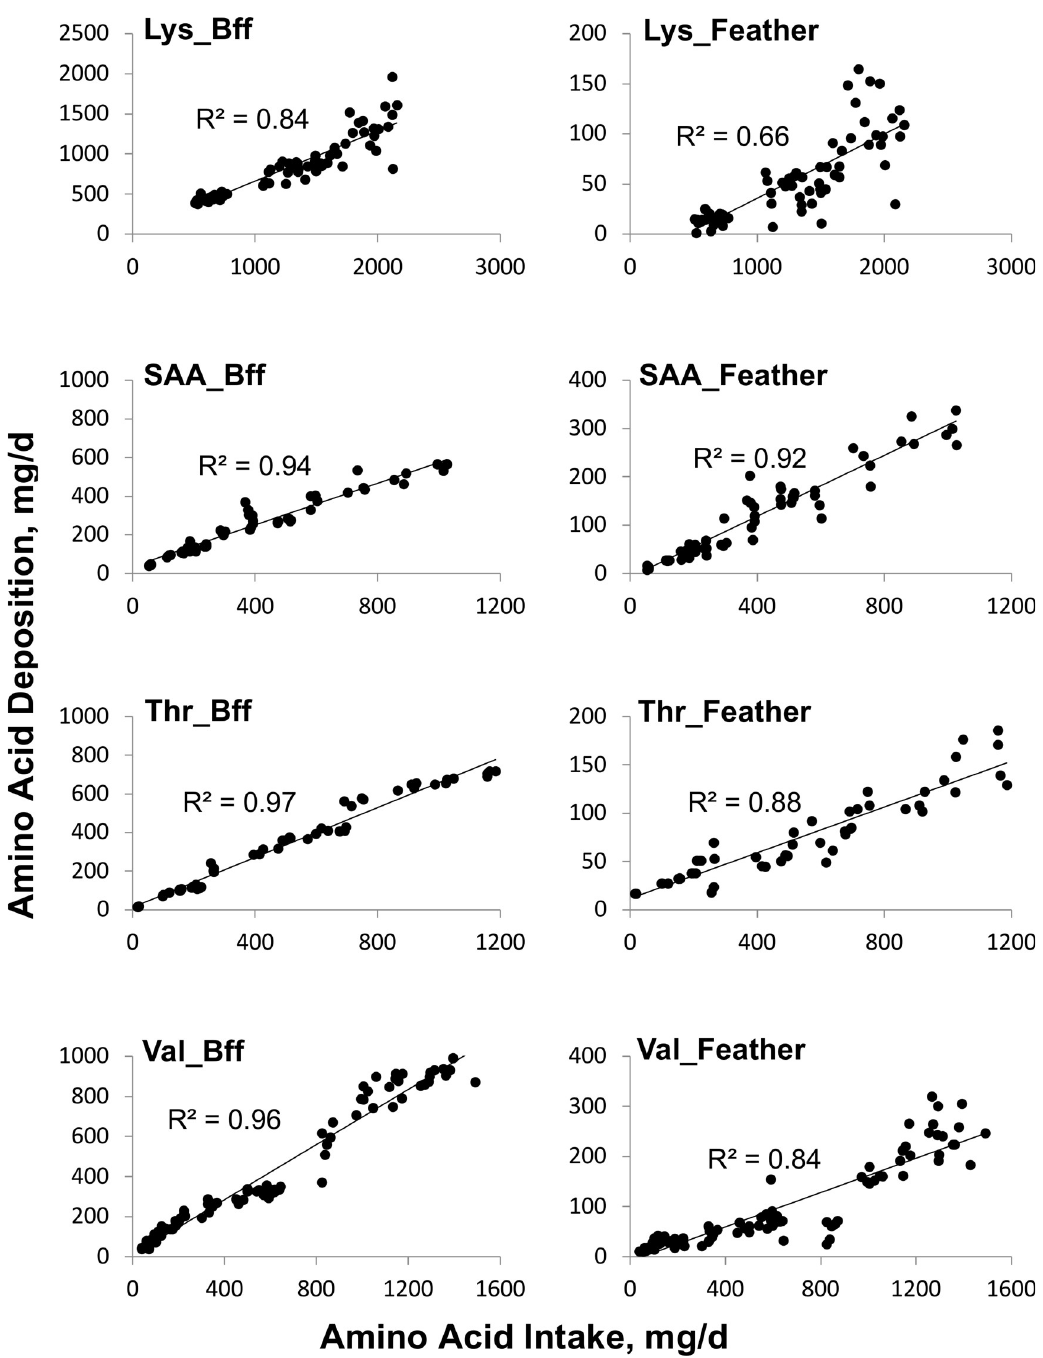
Fig 1. Adjustment of feather-free body ( Bff ) or feather amino acid deposition (mg/bird/day) in function of amino acid intake for gain (mg/bird/day).